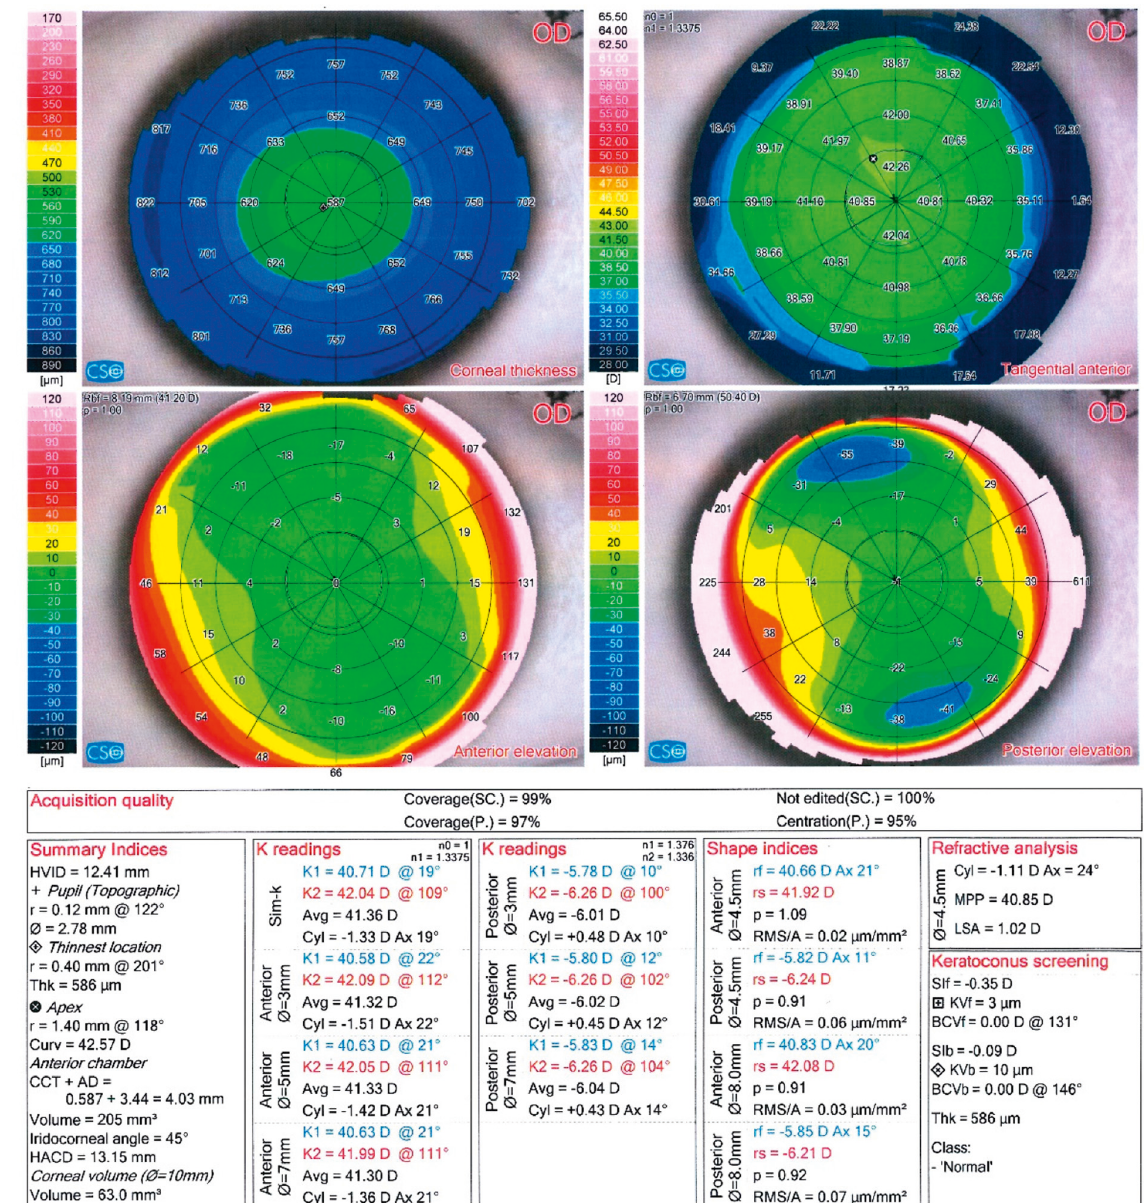
Figure 3: Sirius (v) 2.6 quad map of a case with a normal